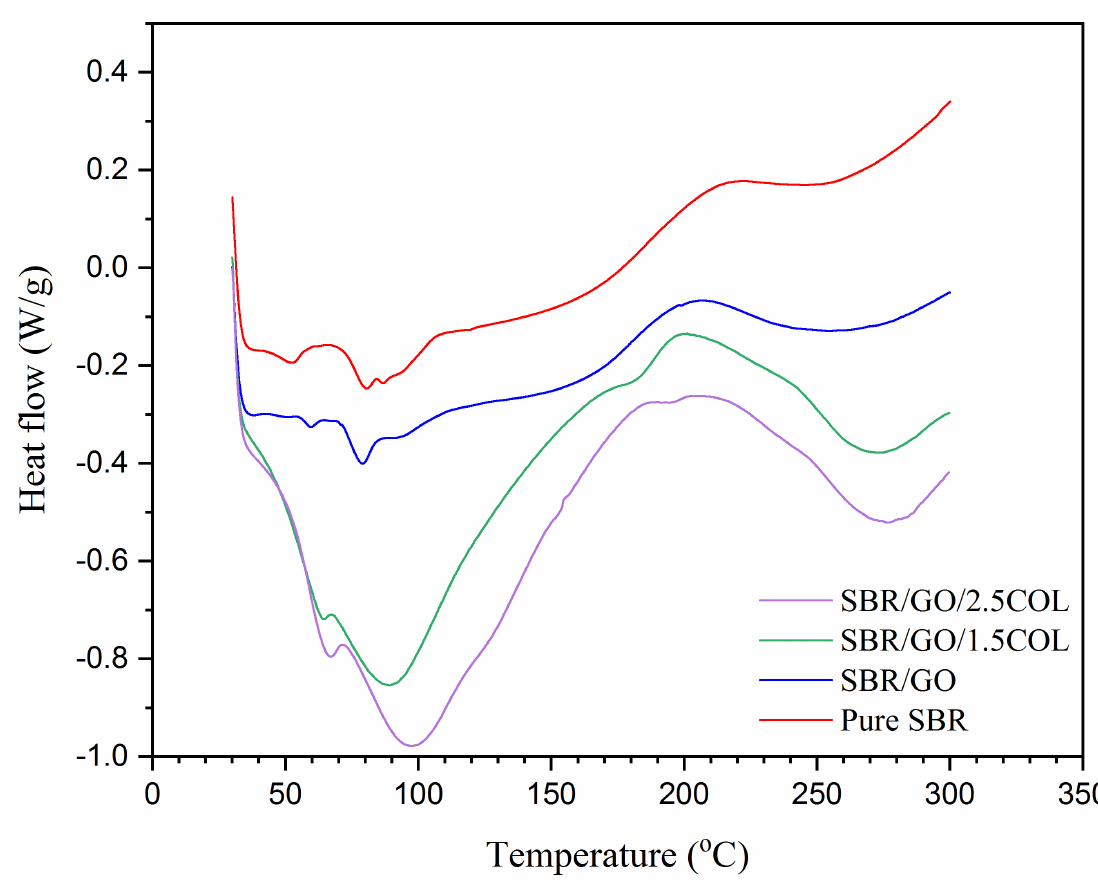
Figure 3. DSC spectra of SBR